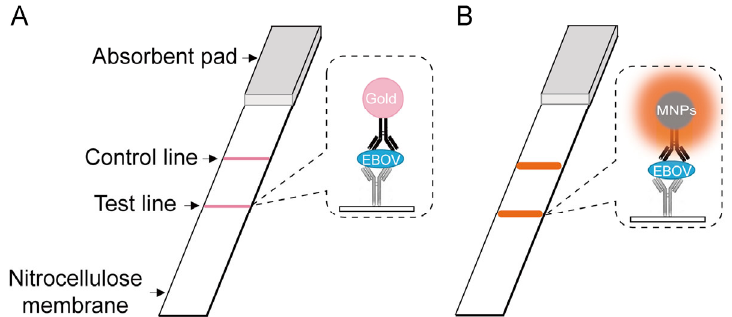
Figure 11. Nanozyme ‐ strip constituents for the rapid diagnosis of Ebola. ( A ) Standard colloidal gold strip. ( B ) Nanozyme gold probe placed in the nanozyme strip. Reprinted with permission from [57]. Copyright © 2015 Elsevier.